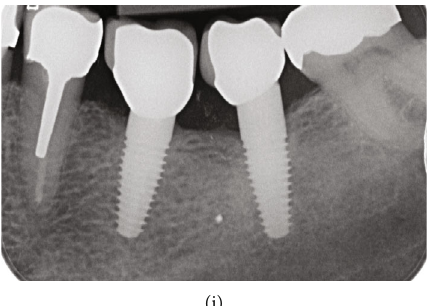
Figure 5: Soft-tissue augmentation in the region of the planned implantation: (a) clinical situation presurgically presenting small alveolar crest and reduced width of keratinized gingiva around implant site; (b) augmentation of free gingival graft at the buccal aspect; (c) clinical situation six weeks after healing; (d) postoperative clinical situation after implantation of two one-piece implants, fl ap closure; (e) clinical situation after 12 weeks of transgingival healing; (f) prosthetic restoration six months after implantation, cemented single crowns; (g) radiographic control after implantation; (h) postsurgical radiograph taken directly after cementation of single crowns; (i) radiographic control nine years after implant